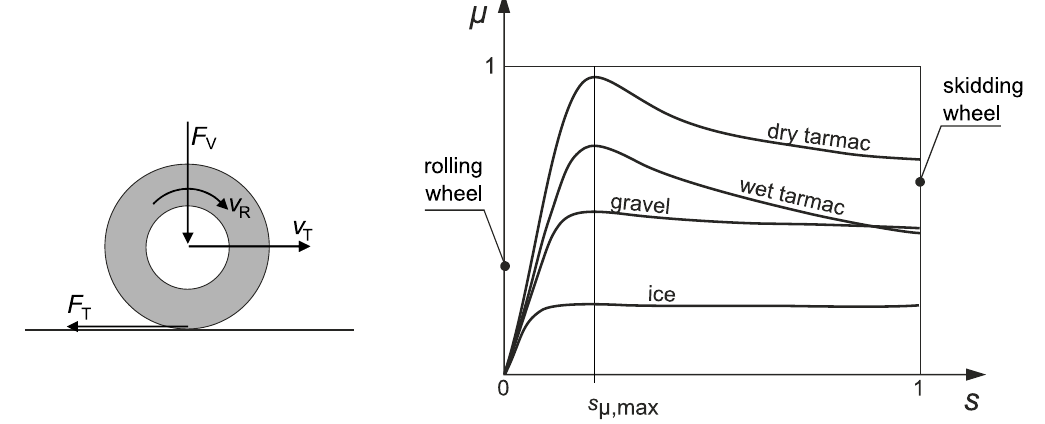
Figure 1. Relation between wheel slip and friction on different surfaces.